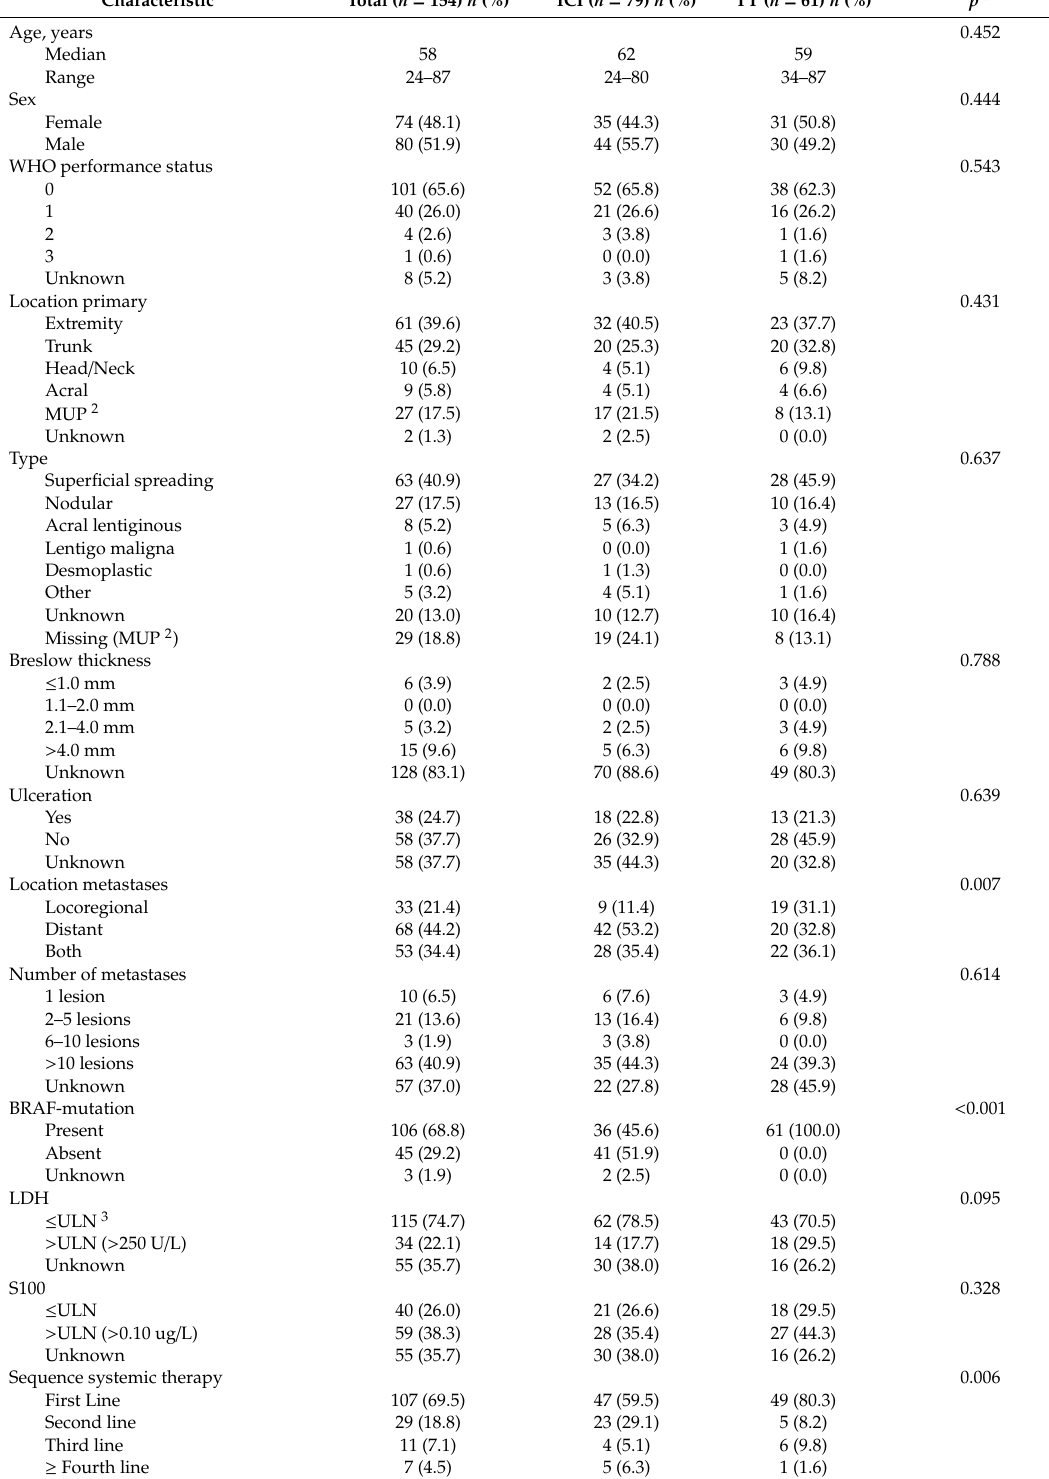
Table 1. Patient, tumor and treatment